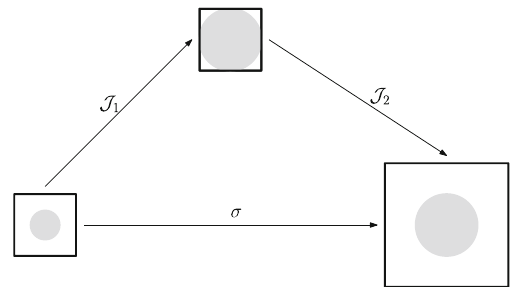
Fig. 2 The determination of the step scaling function σ involves a change in the renormalization scale and in the size of the system of a factor two. These two steps do not need to be performed at the sime time. The figure shows that σ can be determined as the composition of the function J 1 that changes the renormalization scale μ → μ/ 2 at fixed size L , with the function J 2 that changes the size L → 2 L at fixed renormalization scale